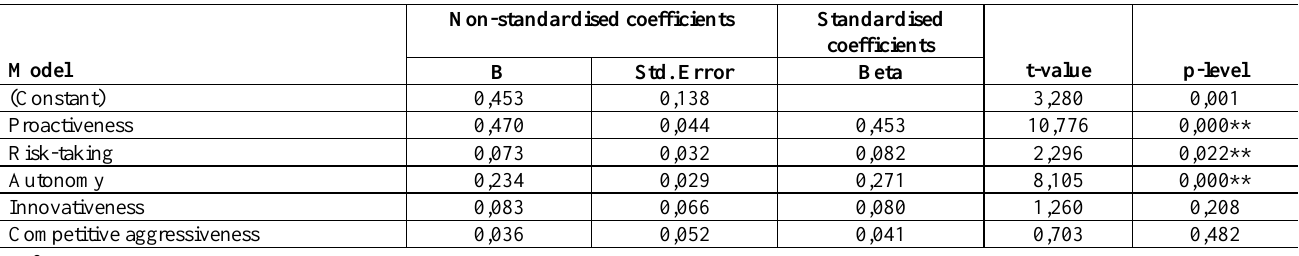
Table 3: Multiple regression results: Impact of the independent variables on the dependent variable Business development and improvement